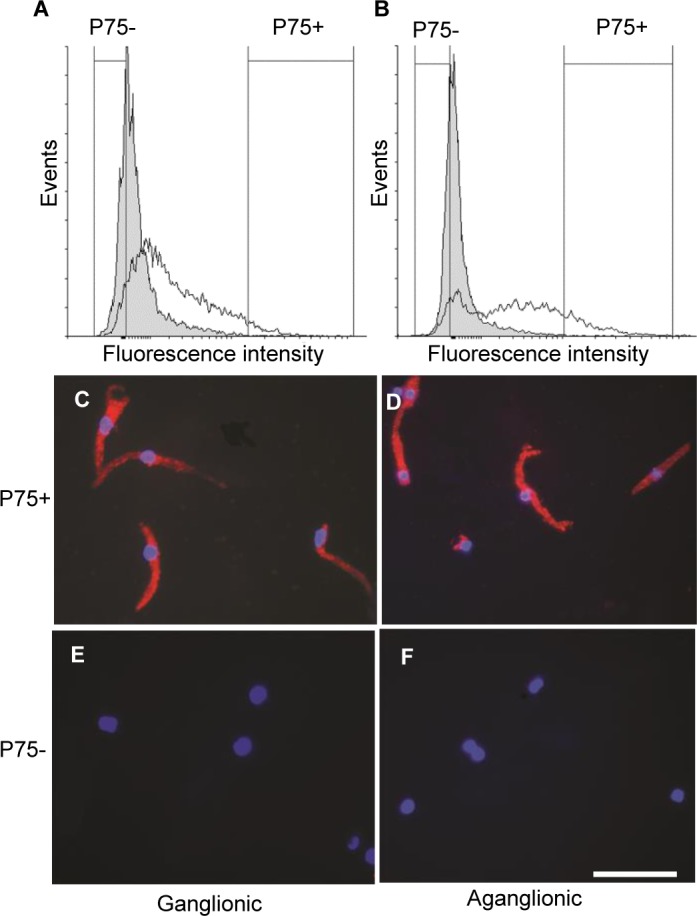
Expression of the pan-neuronal marker Tuj1 in cultures of freshly dissociated cells selected by FACS of p75 positive and negative cell subpopulations.FACS profiles showing numbers of p75 positive cells together with negative controls using isotype primary antibodies (shaded peaks). The range of p75- positive and-negative cells selected for culture from ganglionic gut (A) and aganglionic gut (B) are indicated by vertical lines. Tuj1 immunofluorescence staining of the p75 positive cell subpopulations from ganglionic (C) and aganglionic (D) bowel after 6 days culture. Note that the majority of cells are Tuj1-positive in both samples. Tuj1 immunofluorescence staining of the p75 negative cell subpopulations from ganglionic (E) and aganglionic gut (F). Note the absence of Tuj1 positive cells in both samples. Nuclei are counterstained with DAPI. Scale bar = 20μm.